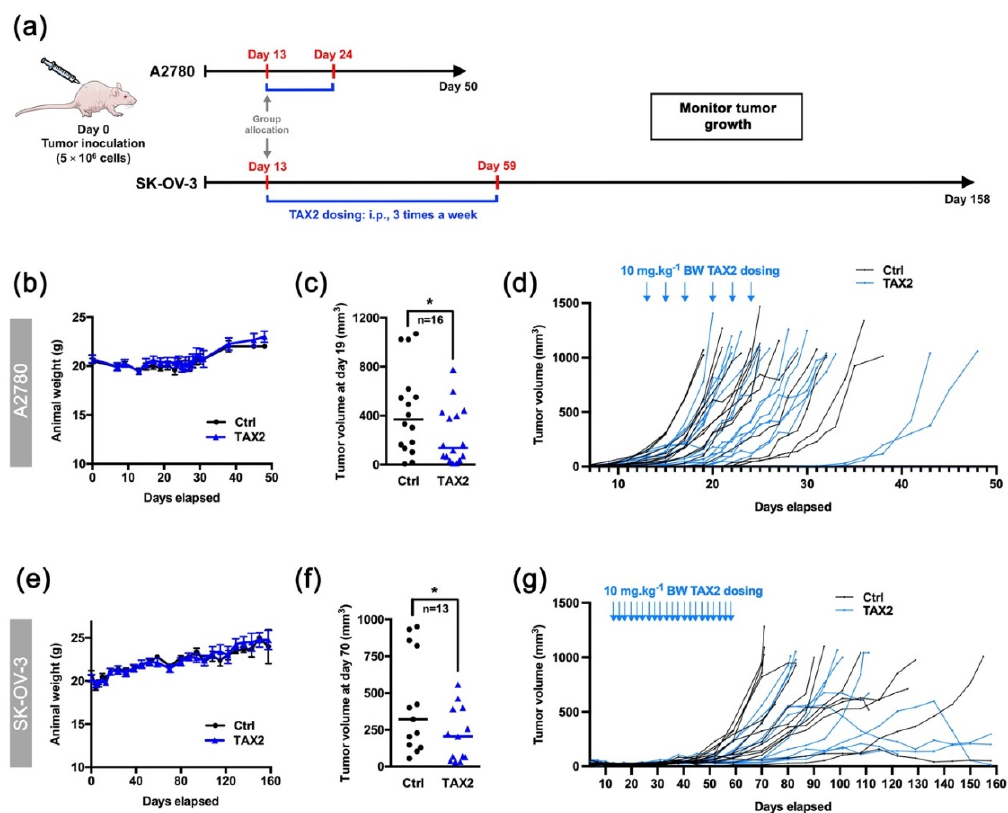
Figure 3. Therapeutic evaluation of TAX2 peptide in the A2780 and SK-OV-3 xenograft models. ( a ) 5 × 10 6 A2780 or SK-OV-3 human ovarian carcinoma cells were s.c. implanted in BALB/c nude mice, and then i.p. administrations of either vehicle (0.9% NaCl) or TAX2 peptide (10 mg · kg − 1 BW) were performed 3 times a week for 2 weeks (A2780 model: b to d or 7 weeks (SK-OV-3 model: e to g ) ( n = 18–22 per group). Before applying first administration on day 13, we ensure that mean tumor volumes between groups were comparable. At treatment administration starting point, note that subcutaneous xenografts had already established tumor vasculature as controlled by micro-computed tomography. Mice were regularly checked for BW, tumor volume and clinical signs. ( b , e ) Evolution of mice body weights (mean ± SEM). ( c , f ) Scatter dot plots of individual calculated tumor volumes before the first animals reached endpoint for euthanasia (>1 cm 3 ), i.e., on day 19 ( c : A2780 model) and on day 70 ( f : SK-OV-3 model), only considering mice having a palpable and measurable tumor at said time-points. Line, median (Mann–Whitney U test, * p < 0.05). ( d , g ) Evolution of individual animal tumor volumes in mm 3